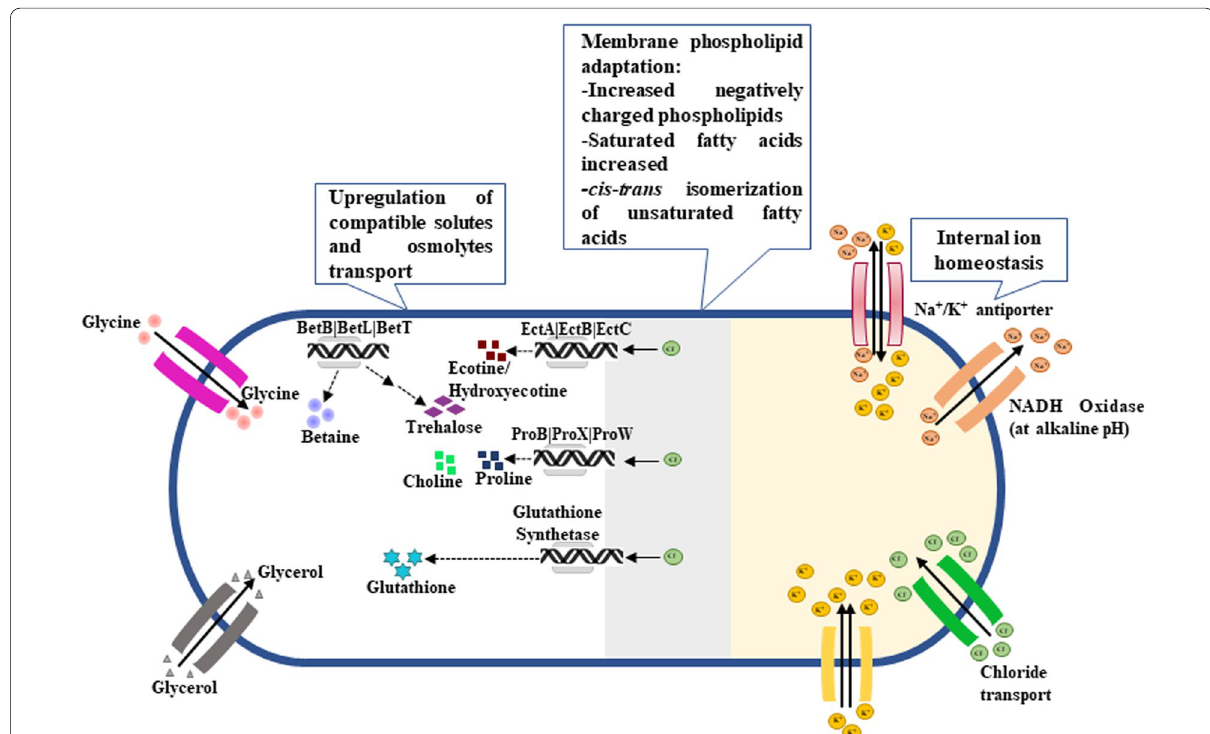
Fig. 1 Schematic representation of the cellular processes involved in salt adaptation in halotolerant